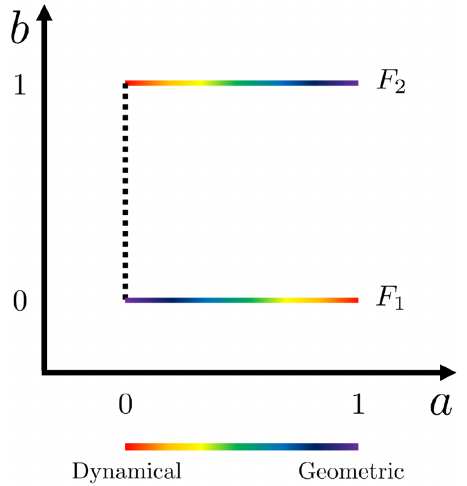
FIG. 10. A schematic illustration demonstrating how control constraints can give rise to preferential phase robustness. Here we consider the set of control Hamiltonians described by Eq. (75). The colored horizontal lines represent families of control Hamiltonians that preserve the filter functions F 1 and F 2 , respec- tively. The color gradient indicates the gate’s phase type, which can range from purely dynamical to purely geometric. The dot- ted line represents a subset of the control space that is physically accessible in a given experiment as a result of strict constraints (generally, this dotted line will broaden into an extended region of the plane). In this case, the constraint prohibits one from traversing the horizontal lines, so one would obtain a different noise sensitivity (i.e., filter function) for a geometric gate versus a dynamical